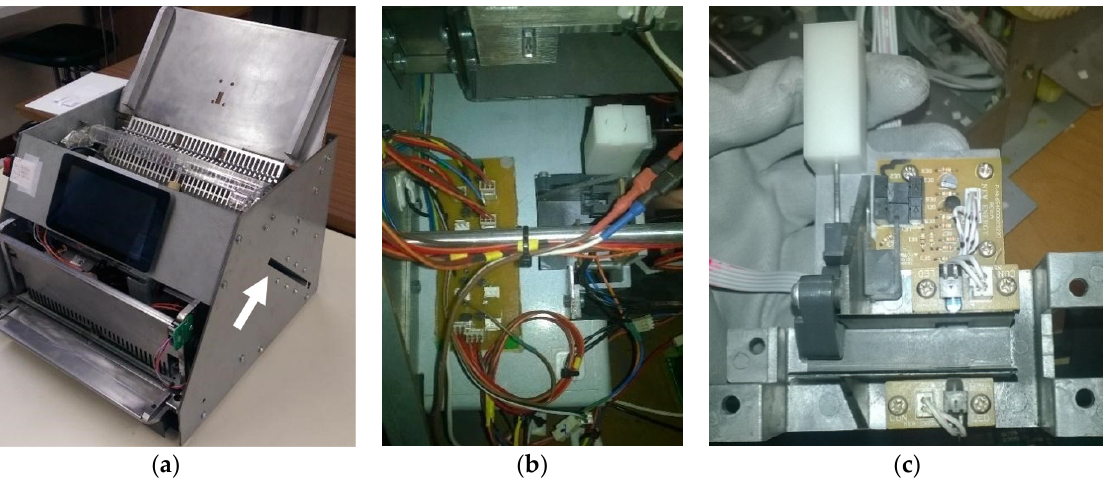
Figure 4. Mechatronic system to measure the document thickness: ( a ) lateral groove in the structure; ( b ) metal structure inside the groove with electronic components attached; ( c ) document thickness measurement mechanical and electronic components.